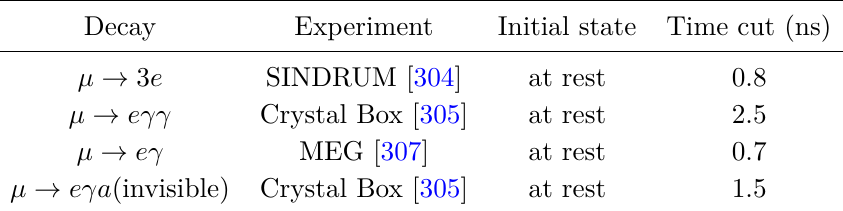
where τ is the proper lifetime of the ALP. We summarise the time cuts that we use in 0 table 10. Sometimes the actual cut as done by the experiment is on the time difference between the detection of various particles in the final state; but we approximate the effects of this by taking this time difference to be a cut on the maximum lab-frame lifetime of the